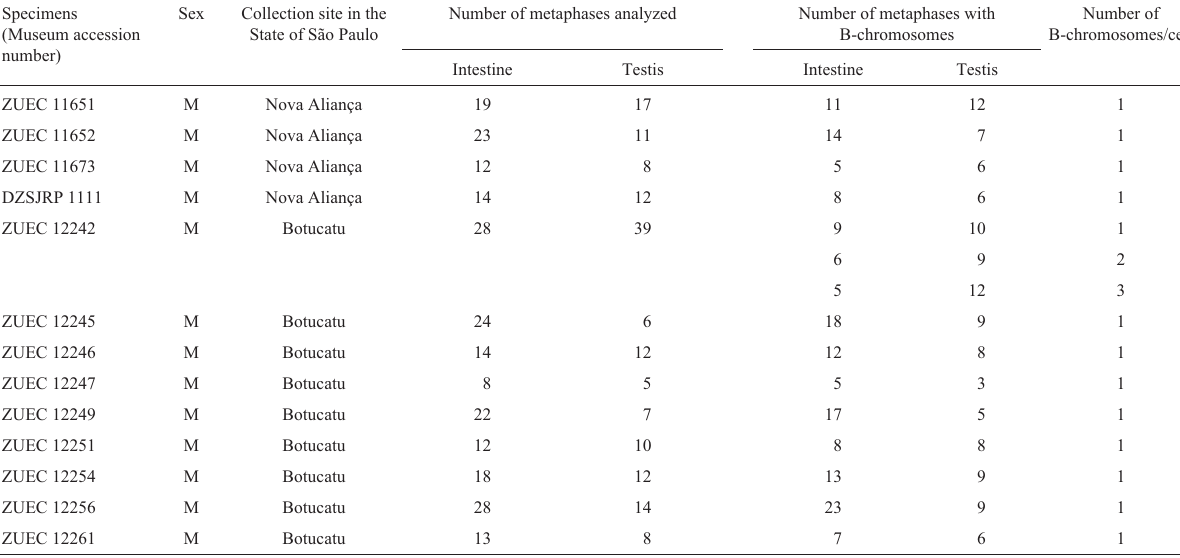
Table 1 - Museum accession numbers of specimens, sex, (locality of) collection site, number of metaphases analyzed and number of B-chromosomes per cell in Dendropsophus nanus